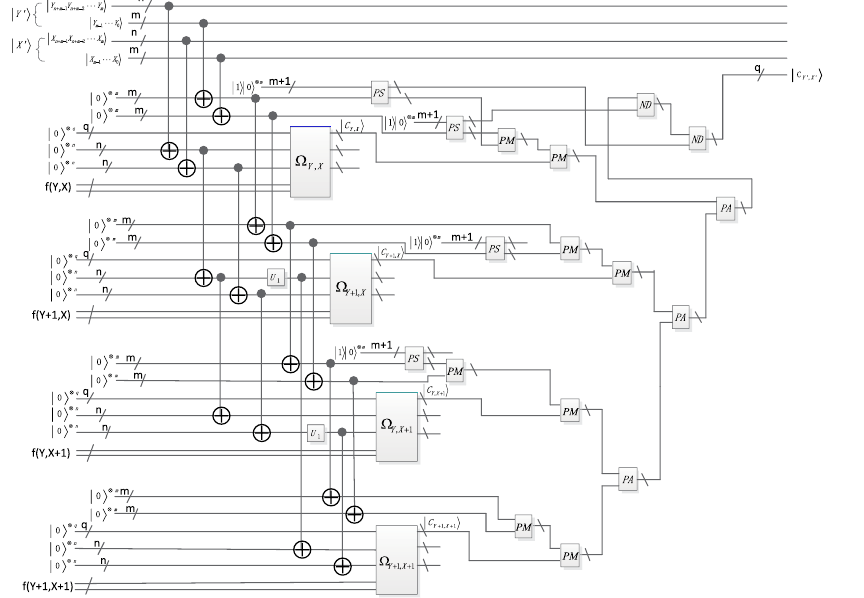
Figure 22. The scaling-up circuit of bilinear interpolation method for